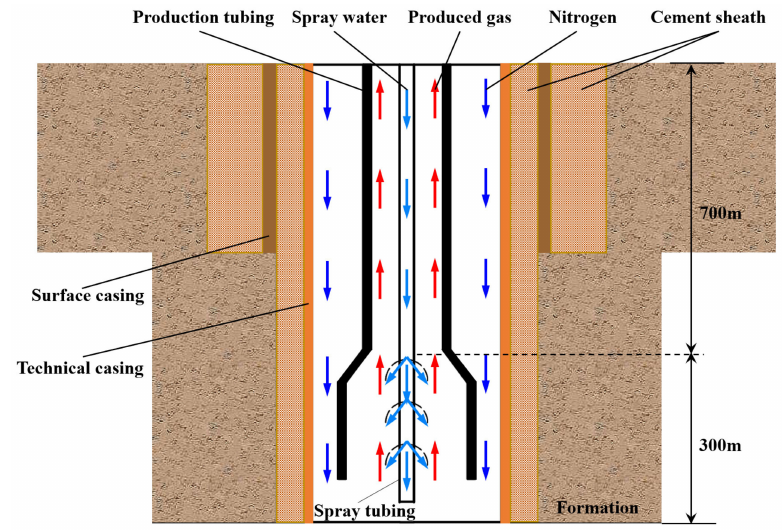
Figure 1. Spray tubing water injection spray cooling